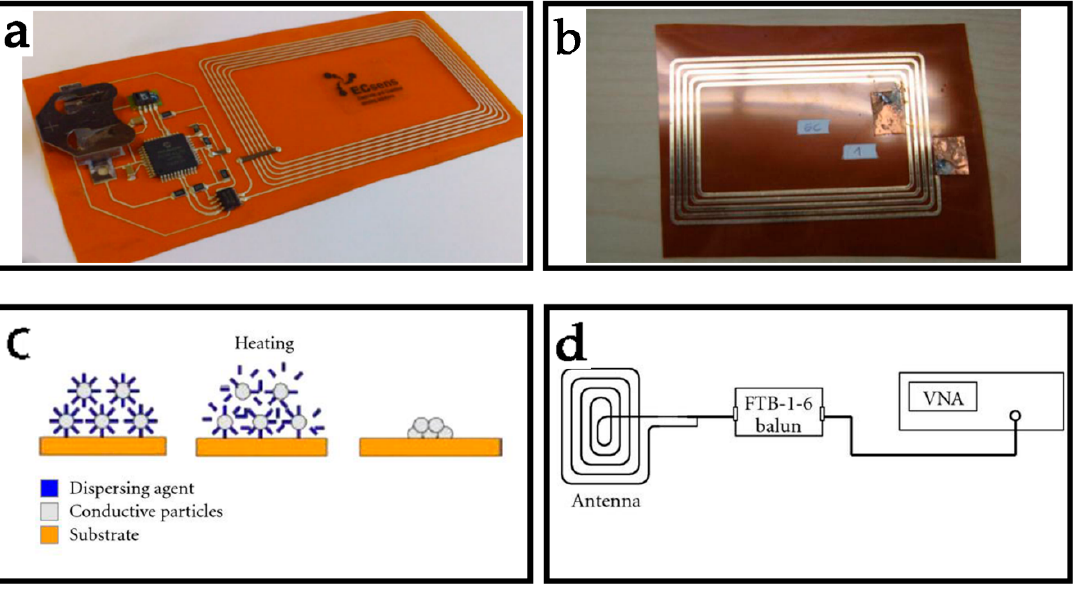
Table 4. References of NFC sensors.